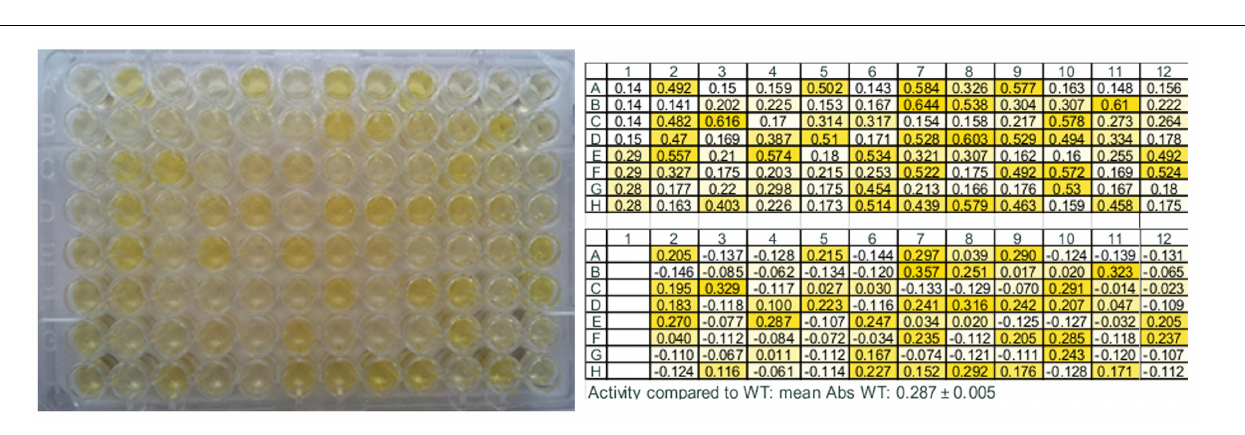
FIGURE 3 | (A) Color development of the acetophenone-vanillin reaction with different acetophenone concentrations over time. Concentrations (from top to bottom): 10, 8, 6, 4, 2, 1, 0 mM acetophenone. Reaction conditions to simulate realistic assay conditions: 30 mM tert -butyl hydroperoxide, 10–0 mM acetophenone and formaldehyde, 0–10 mM α -methylstyrene, 1 mg/mL Escherichia coli BL21 (DE3) Gold lysate with overexpressed CupinX (a cupin protein without alkene cleavage activity) in 50 mM NaPi, pH 7.0, in a total volume of 150 µ L. 40 µ L of detection solution consisting of 5 M NaOH, 2.5% vanillin and 50% ethanol were added to start the color reaction. (B) Standard curve of acetophenone in the range of 1–10 mM (in a total volume of 150 µ L in 50 mM NaPi, pH 7.0) detected with 40 µ L of detection solution (2 M NaOH, 3.5% vanillin and 10% EtOH) for 30 min at room temperature. Absorption was measured at 450 nm.